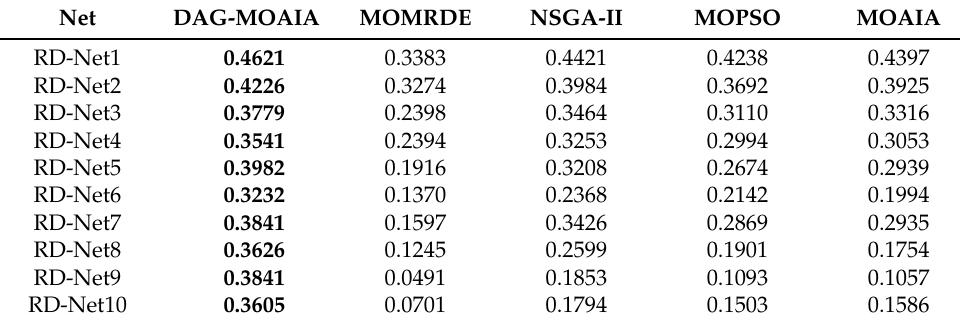
Table 4. Mean values of HV (best results are shown in bold).